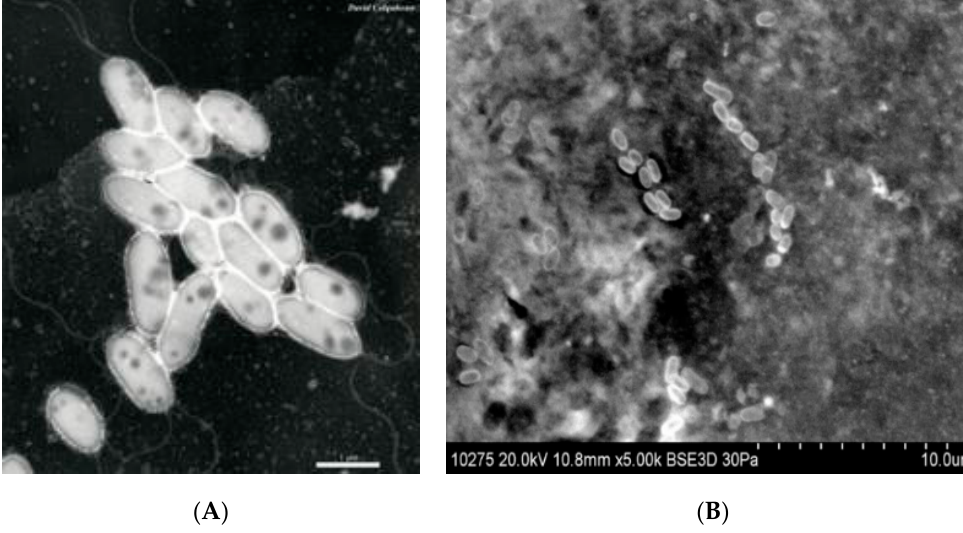
Figure 5. Sphingomonas ( A ) and other, rod-shaped bacteria on the surface of an autopsied membrane ( B ). ( A ) scale = 1 micron, ( B ) scale = 10 microns.